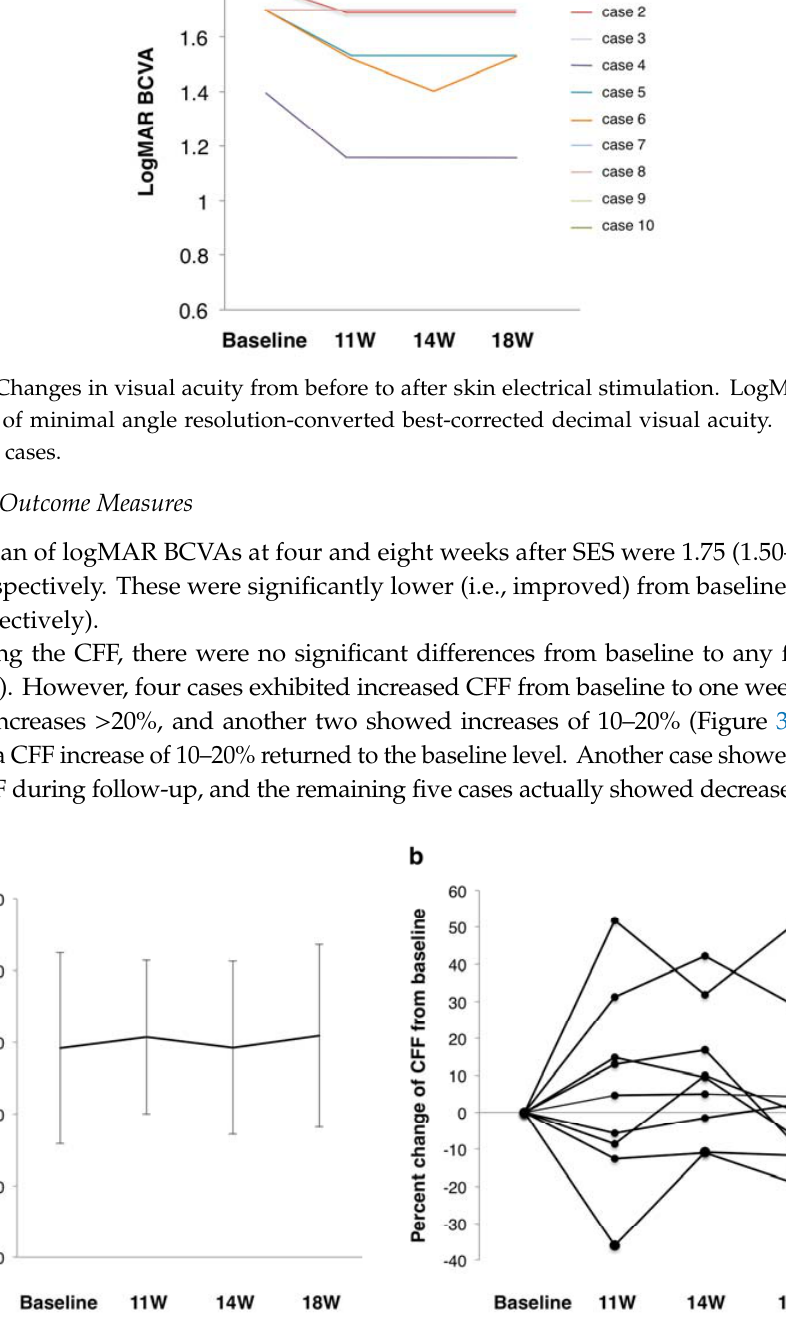
Figure 3. Changes in CFF before and after SES: ( a ) mean changes, where error bars indicate standard deviations; and ( b ) percent change from baseline. CFF, critical flicker frequency; SES, skin electrical stimulation.